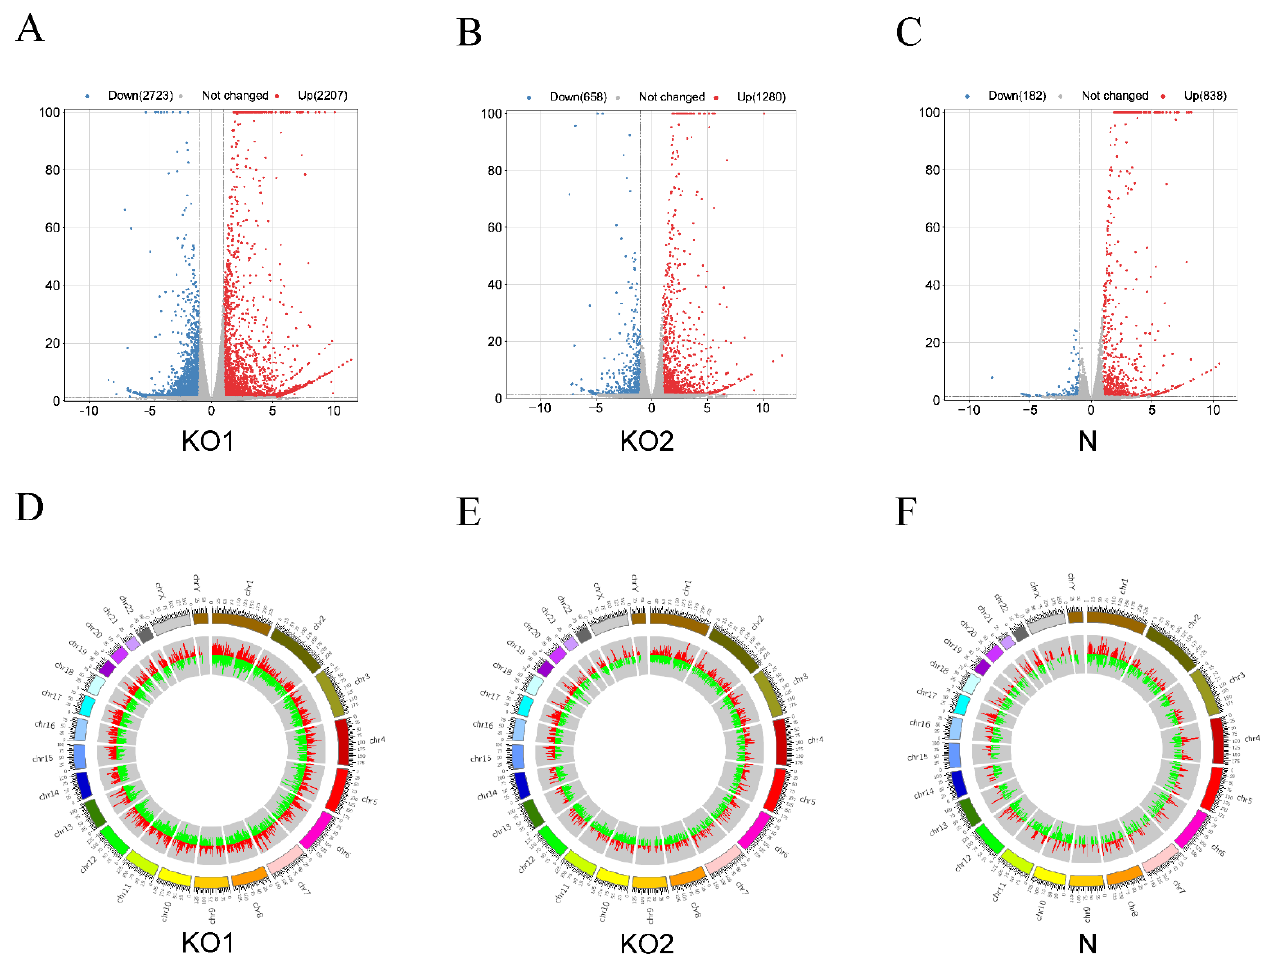
Figure 3. Screening and classification of differentially expressed genes (DEGs). ( A – C ) Volcano plots of the three groups (KO1, KO2, and N). Red- and blue-colored dots represent upregulated and downregulated genes, respectively (adjusted P-value < 0.05 and |log2 fold change| > 1). Gray- colored dots represent loci with no significant differential expression. ( D – F ) Circos plots showing DEGs (red column) and DEHERVs (green column) across chromosomal locations. The length of the column represents the absolute value of the log2 fold change.